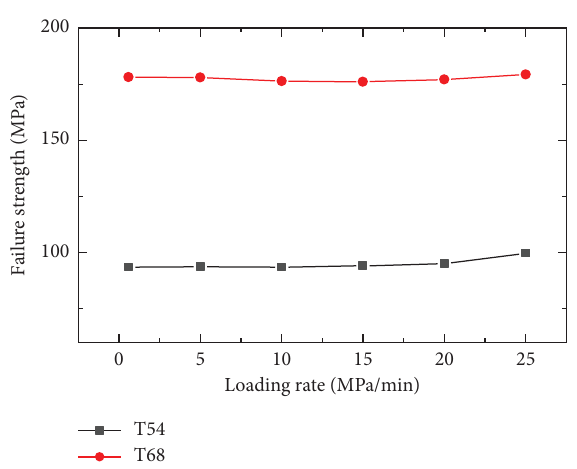
Figure 10: Failure strength vs. loading rate.